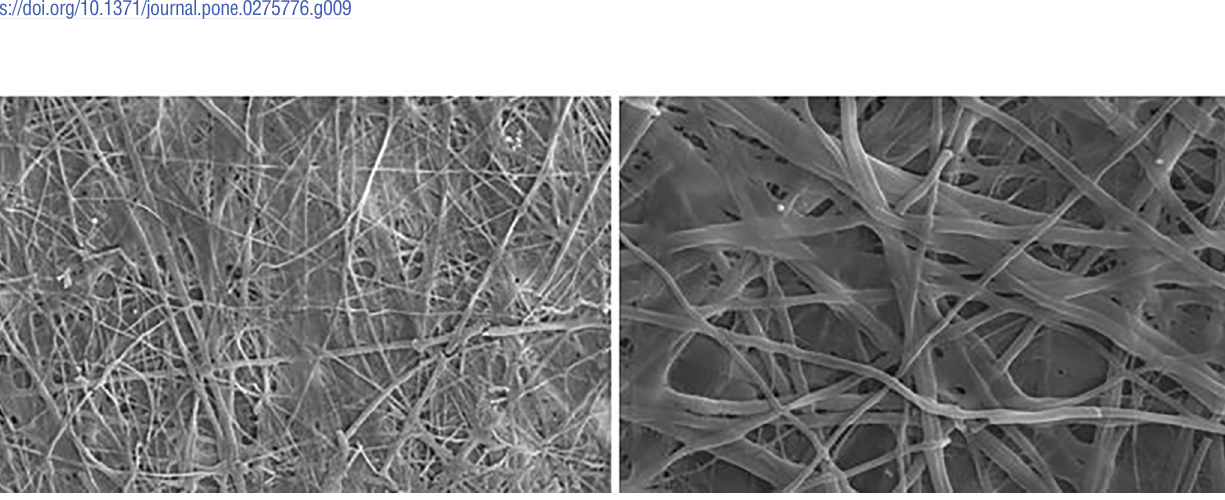
Fig 10. The scanning electron microscope (SEM) of MCF7 adhesion and spreading on polylactic acid scaffolds during 6 days of incubation.